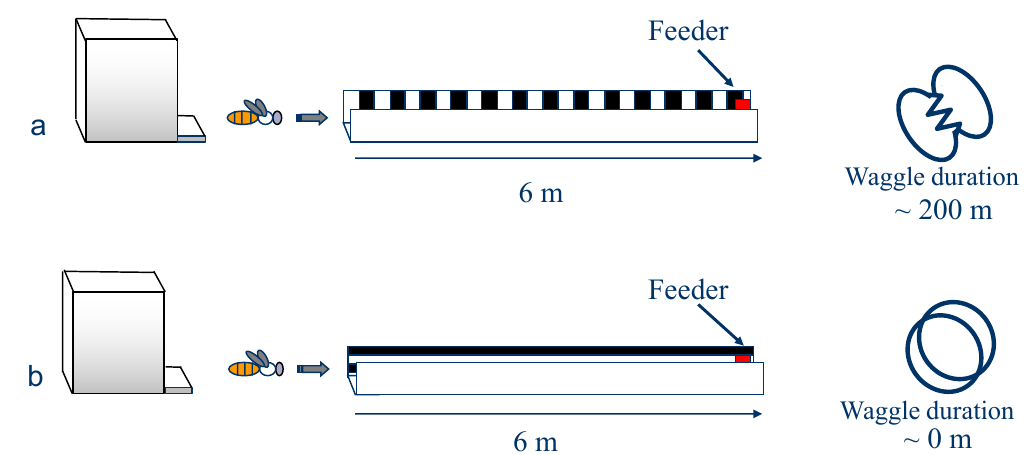
Figure 5. Honeybee odometry, investigated via the waggle dance. ( a ) Bees are trained to visit a feeder positioned at the end of a short, narrow tunnel near the hive entrance. The returning bees perform a strong waggle dance indicating a travel distance of 200 m, massively overestimating the distance that they have flown in the tunnel; ( b ) When image motion cues are eliminated by decorating the tunnel walls with horizontal, rather than vertical stripes, the bees display no waggle phase, indicating that their perception of travel distance is based on the extent to which the image of the environment has moved in the eyes during the journey from the hive to the food source. Reproduced with permission from